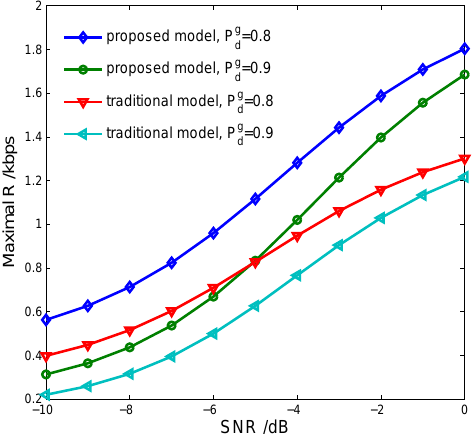
Figure 9. Maximal throughput versus spectrum sensing models.